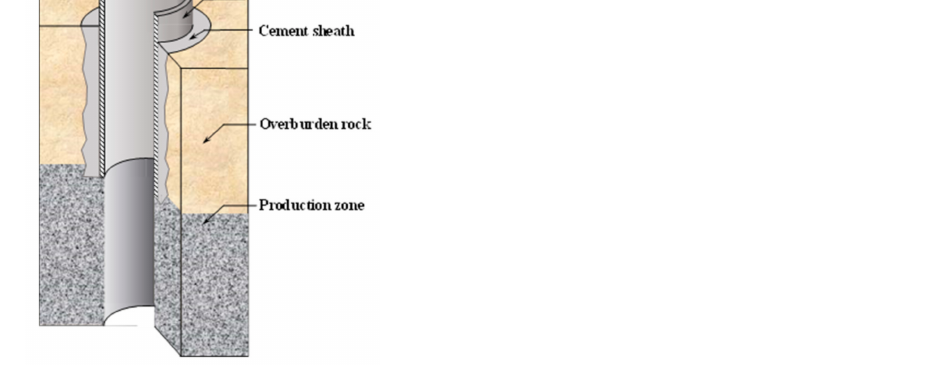
Figure 1. Schematic diagram of a geothermal well structure in northern Shandong.